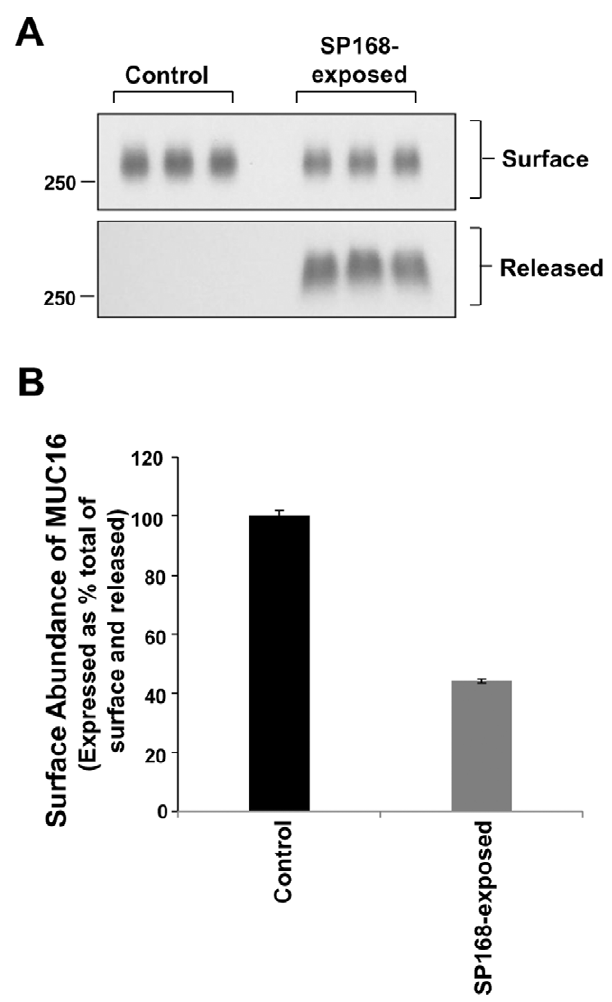
Figure 3. Apical cell surface abundance of MUC16 is reduced following treatment of epithelia with SP168 growth culture filtrate. Apical membrane levels of MUC16 were determined by cell surface biotinylation. A ) Western blot analyses (using M11 antibody) of the amount of released and residual biotin-labeled surface MUC16 after exposure to medium only control or SP168 growth culture filtrate. B ) Quantitative analyses of the western blot in (A) showing a reduction in the abundance of surface MUC16 following treatment with the SP168 culture filtrate (p , 0.0001, Student’s t-test, n=3). Data for MUC16 surface abundance is expressed as a percentage of the total released plus surface MUC16 6 SEM.